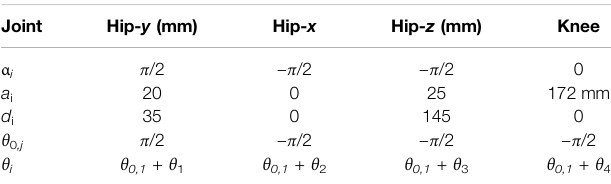
TABLE 1 | DH Table of the joint leg